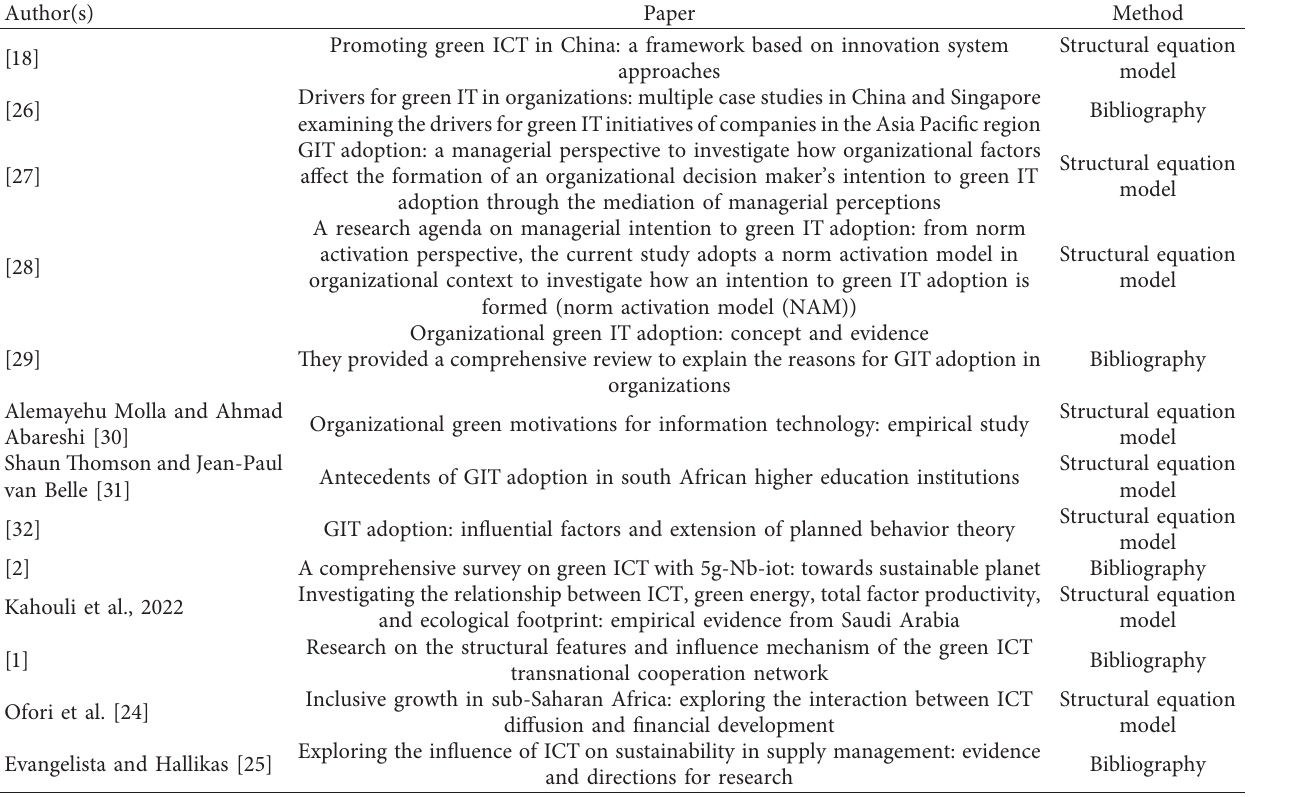
Table 1: A summary of GIT adoption